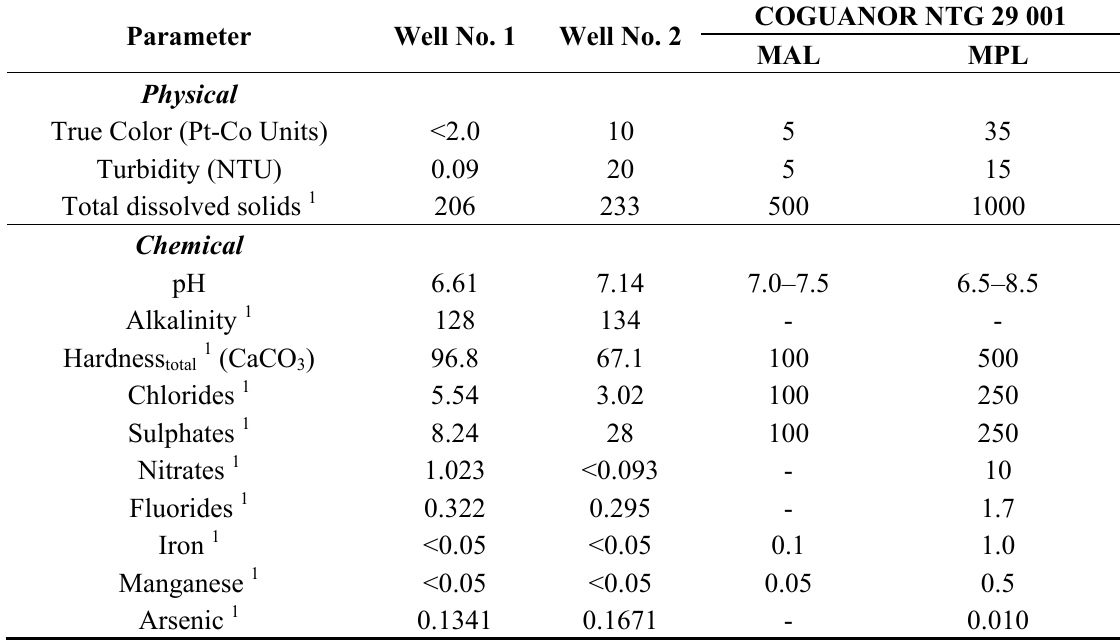
Table 1. Physicochemical characterization of raw